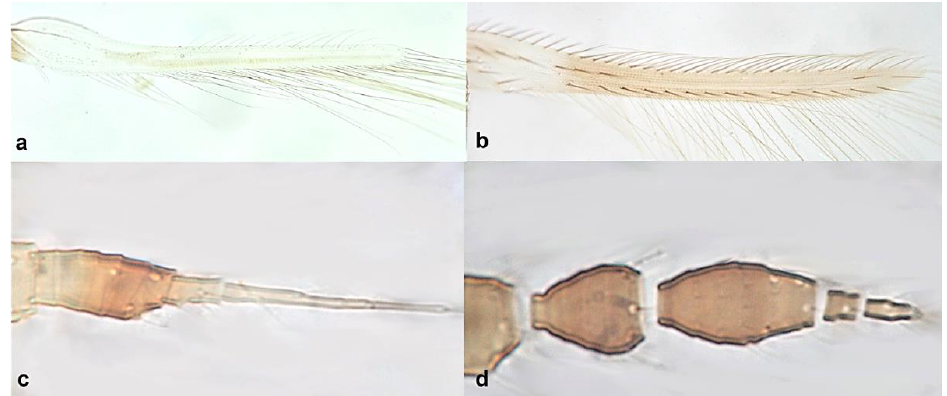
Figure 17. Pterothorax ( a , b ): ( a ) with lyre-shaped metathoracic endofurca; ( b ) with metathoracic endofurca not lyre-shaped; tergites ( c , d ): ( c ) median setae close to each other; ( d ) median setae far away from each other. 17 Fore wing with one row of postero-marginal cilia (Figure 18a); antennal segments VI– VIII long and slender when compared with basal segments. (Figure 18c)...................... Fore wing with two rows of postero-marginal cilia (Figure 18b); antennal segments VI–VIII not sharply elongated (Figure 18d) .............................................. Thripinae .. 19